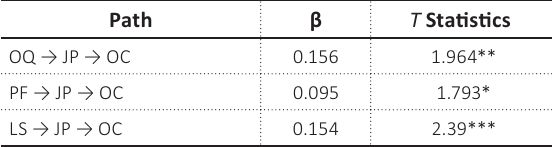
Table 5. Specific indirect